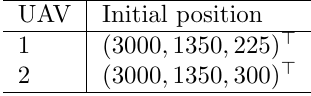
Table 2: Initial position of UAVs